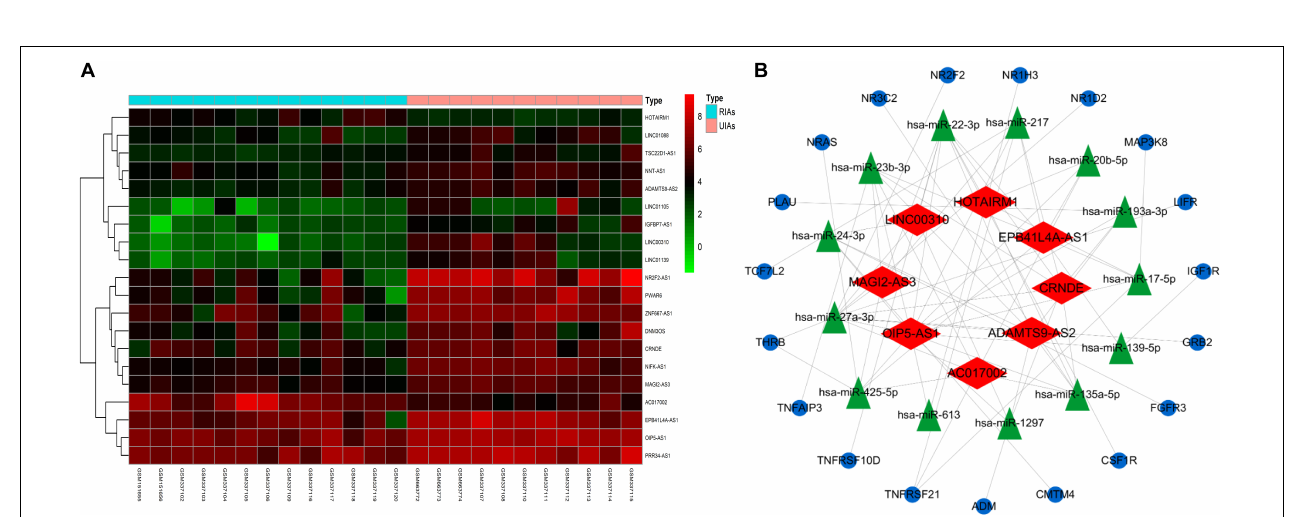
FIGURE 6 | CeRNA network construction. (A) Differential expression heatmap of DElncRNAs. Blue represents RIAs, and orange represents UIAs. (B) CeRNA networks of UIAs and RIAs, which contain 8 DElncRNAs, 13 DEmiRNAs, and 19 DEmRNAs. The blue ellipse represents DEmRNAs, and the green triangle represents DEmiRNAs. The red diamond represents DElncRNAs. DEmRNAs, differentially expressed mRNAs; DEmiRNAs, differentially expressed microRNAs; DElncRNAs, differentially expressed lncRNAs.